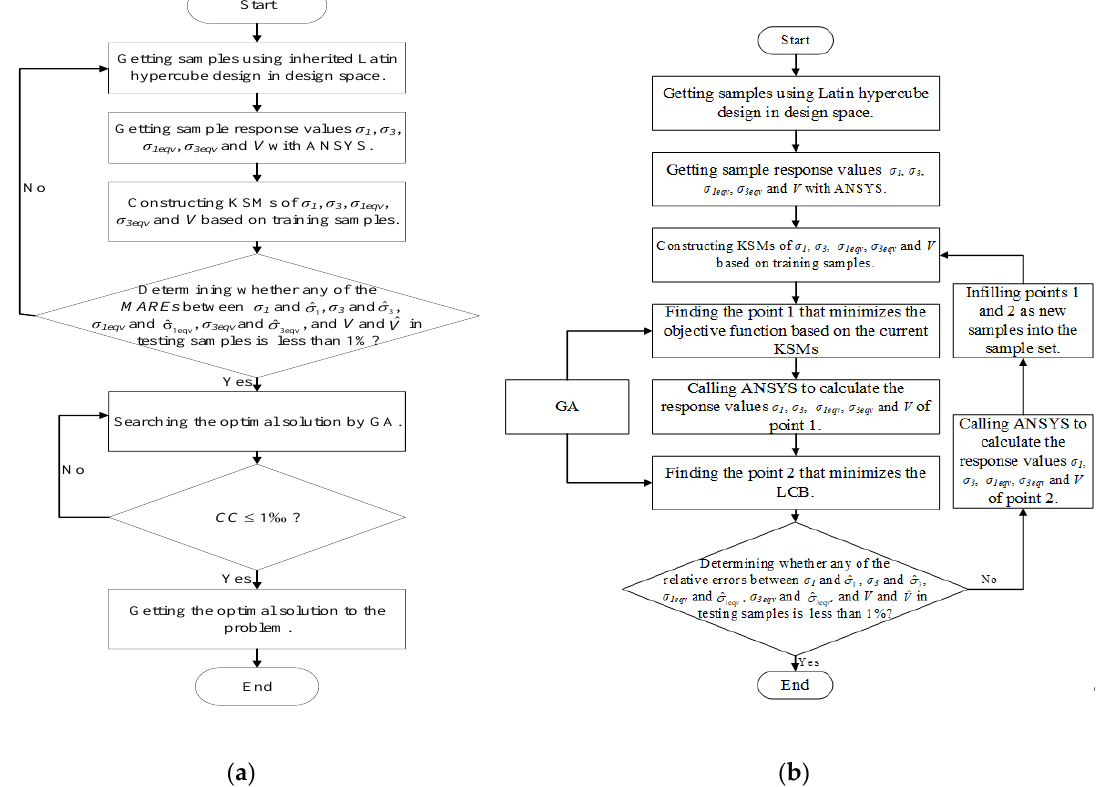
Figure 2. Schematic flowchart of ( a ) a genetic algorithm with a Kriging surrogate model (GA-KSM) and ( b ) a genetic algorithm with a sequential Kriging surrogate model (GA-SKSM).